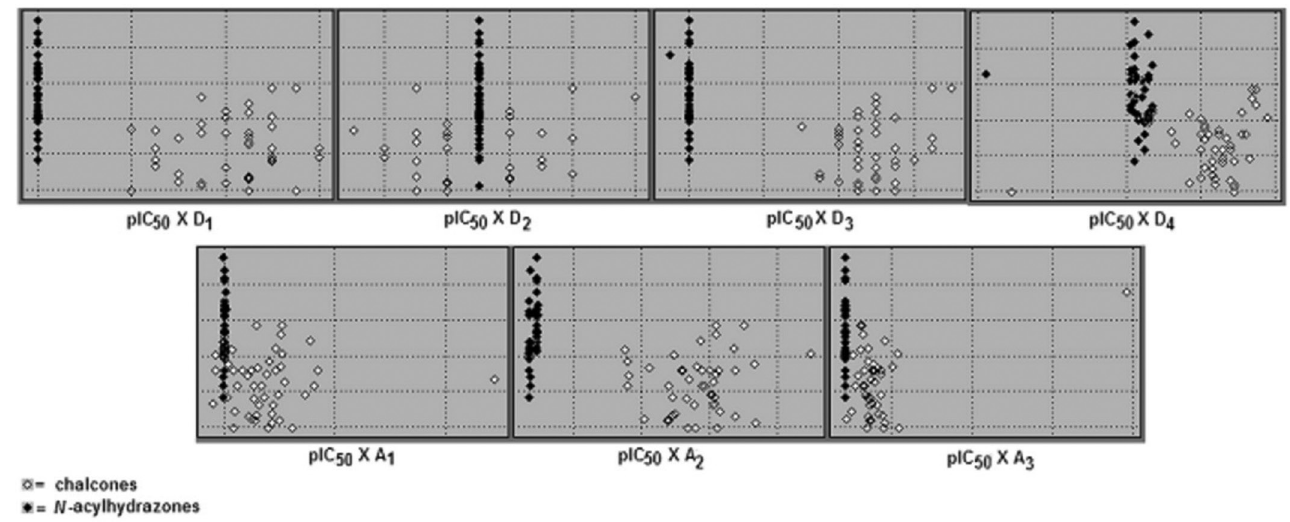
FIGURE 2 - Scatter plots of biological activity (pIC